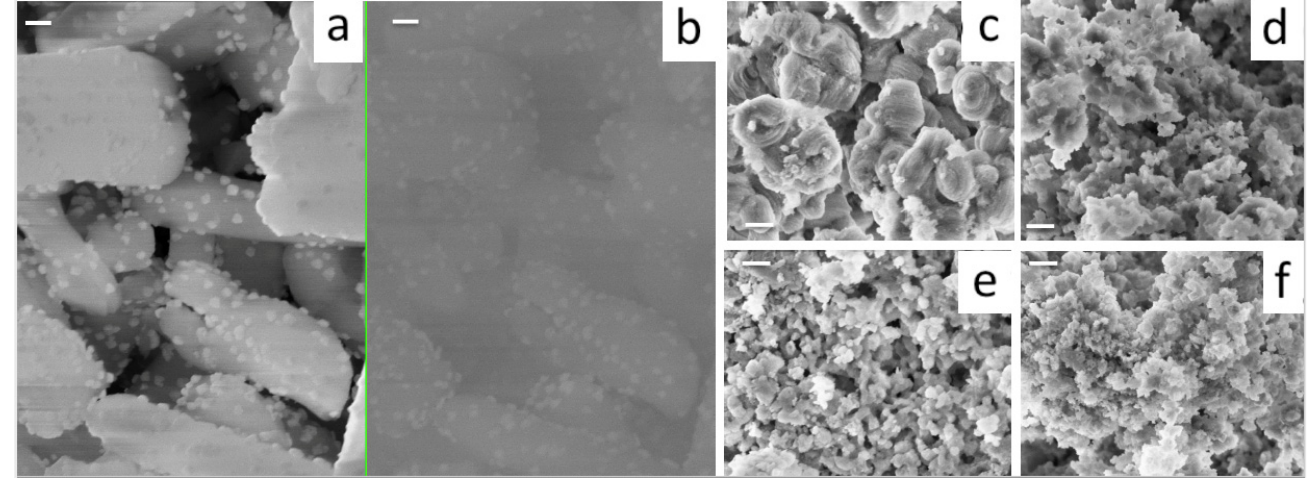
Figure 6. SEM Micrographs for 10% Ni/MCM-41: ( a ) Obtained using the In-lens detector. ( b ) Z-contrast image acquired using backscattered electrons. Particle morphology for: ( c ) Ni/0.02Ce-MCM- 41_US, ( d ) Ni/0.04Ce-MCM-41_US, ( e ) Ni/0.06Ce-MCM-41_US and ( f ) Ni/0.08Ce-MCM-41_US catalysts. (Bar length = 200 nm, magnification 100 kX for all